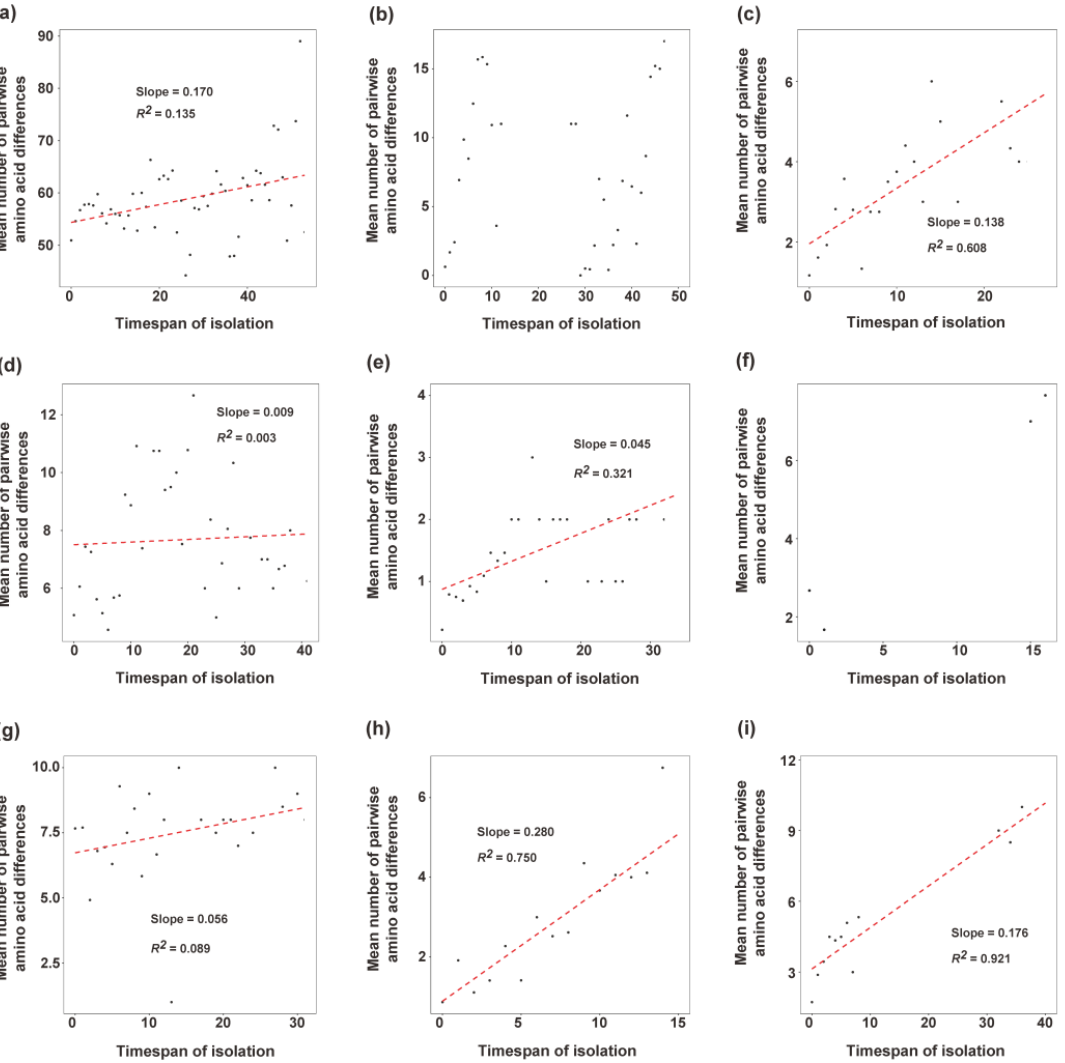
Figure 3. Amino acid accumulation pattern of norovirus GI RdRp gene: ( a ) all strains, ( b ) GI.P1, ( c ) GI.P2, ( d ) GI.P3, ( e ) GI.P4, ( f ) GI.P6, ( g ) GI.P7, ( h ) GI.P11, ( i ) GI.P13. The X-axis is the timespan of isolation, and the Y-axis indicates the mean number of pairwise amino acid differences. Red dashed line shows a linear regression line.